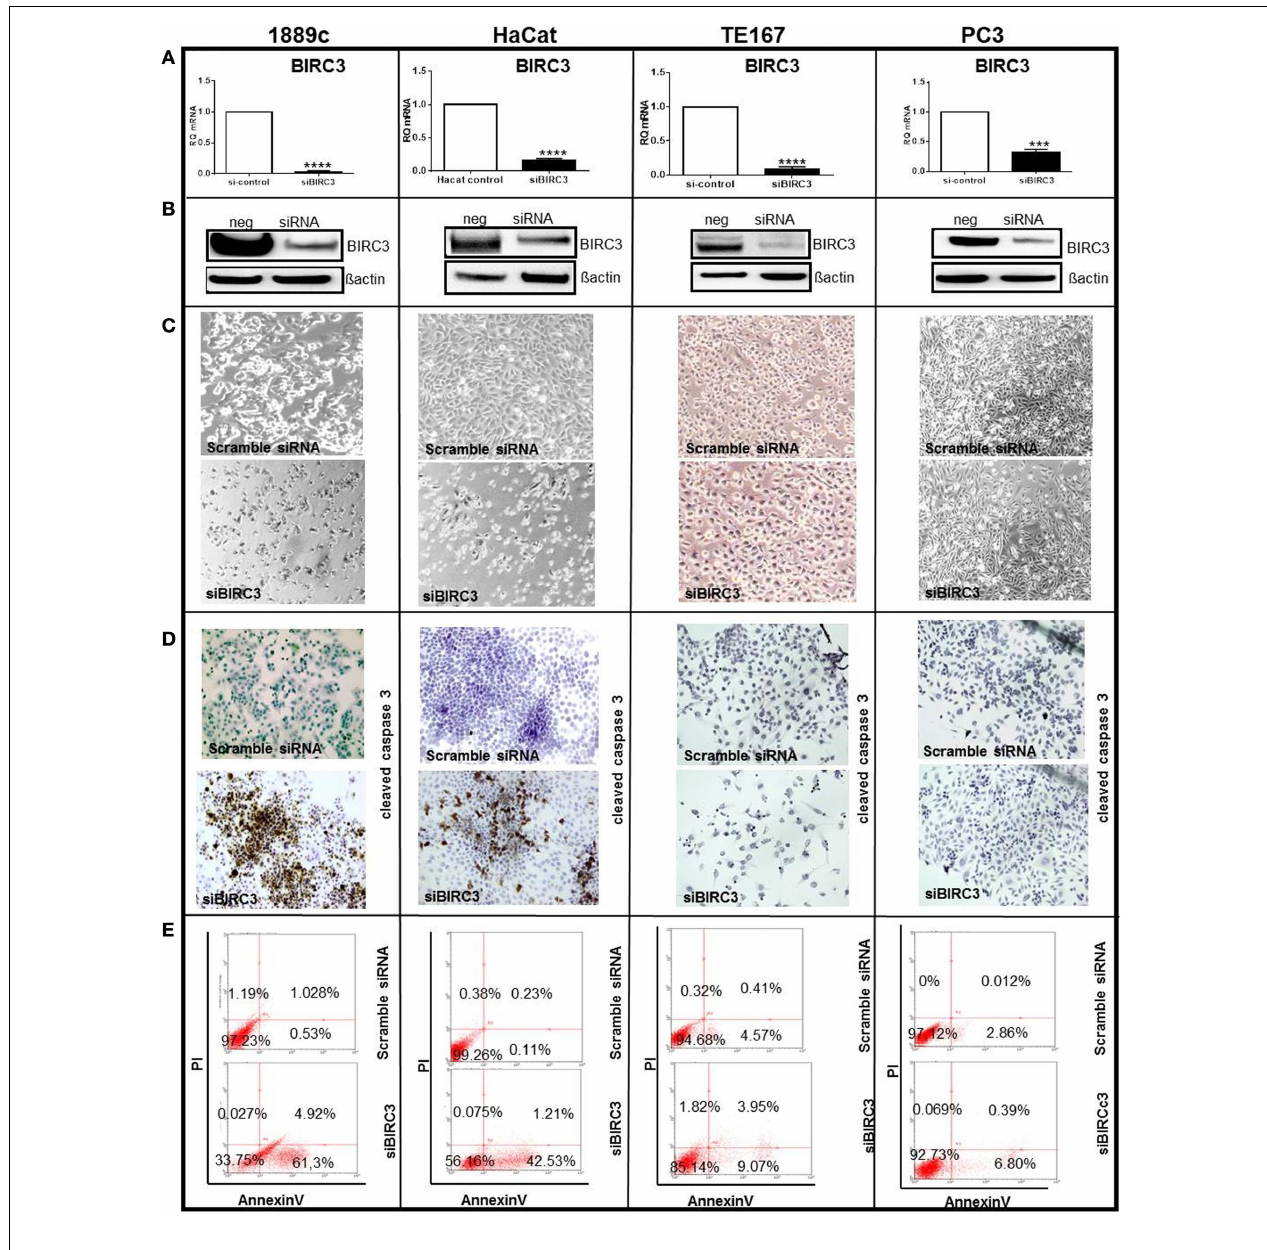
apoptosis detection (immunoperoxidase × 20) (D) . FACS analysis to quantify apoptosis using AnnexinV-FITCS/PI (E) . All experiments were done in triplicate and each measurement in duplicate. Similar low levels of apoptosis following si-BIRC3 transfection were observed in A549 (lung carcinoma); MCF7 (breast carcinoma); and HeLa (cervical adenocarcinoma) cells.